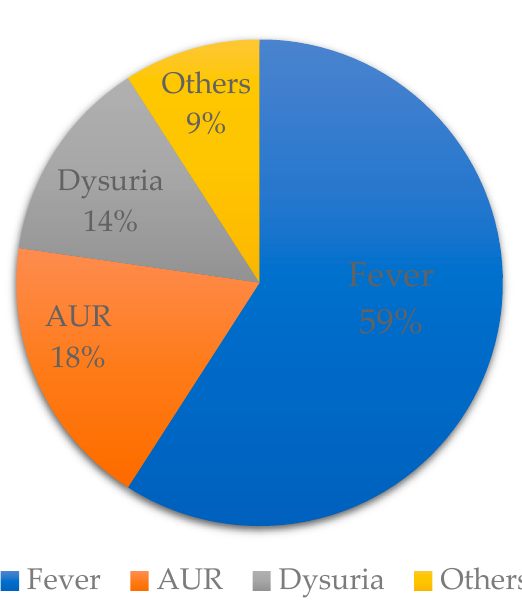
Figure 1. Flow chart of retrospective analysis of the patients with a prostate abscess.